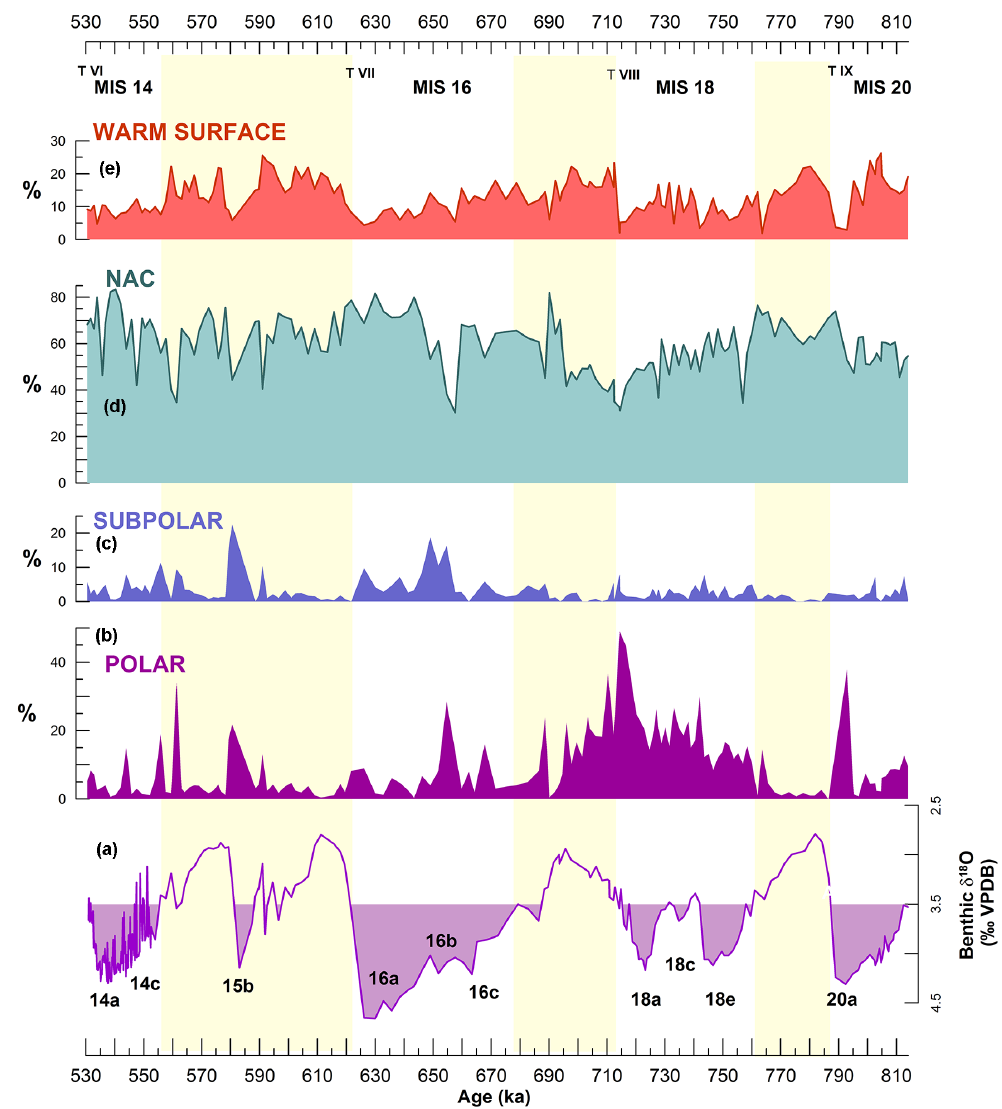
Figure 2. Relative abundance of planktonic foraminiferal species and assemblages in IODP-U1385 through MIS14–MIS20, and comparison with benthic isotope data from the same site. (a) Benthic δ 18 O record (Hodell et al., 2015) with filling enhancing glacial conditions according to the threshold for the North Atlantic (McManus et al., 1999); glacial substages are named according to Railsback et al. (2015). Relative abundance of (b) polar species N. pachyderma sinistral; (c) subpolar species T. quinqueloba ; (d) NAC assemblage (as defined by Ottens, 1991); and (e) warm surface assemblage (as defined by Vautravers et al., 2004). Yellow bands highlight interglacials. Terminations (T) are marked in Roman numerals. IODP-U1385 isotopic record is from Hodell et al.